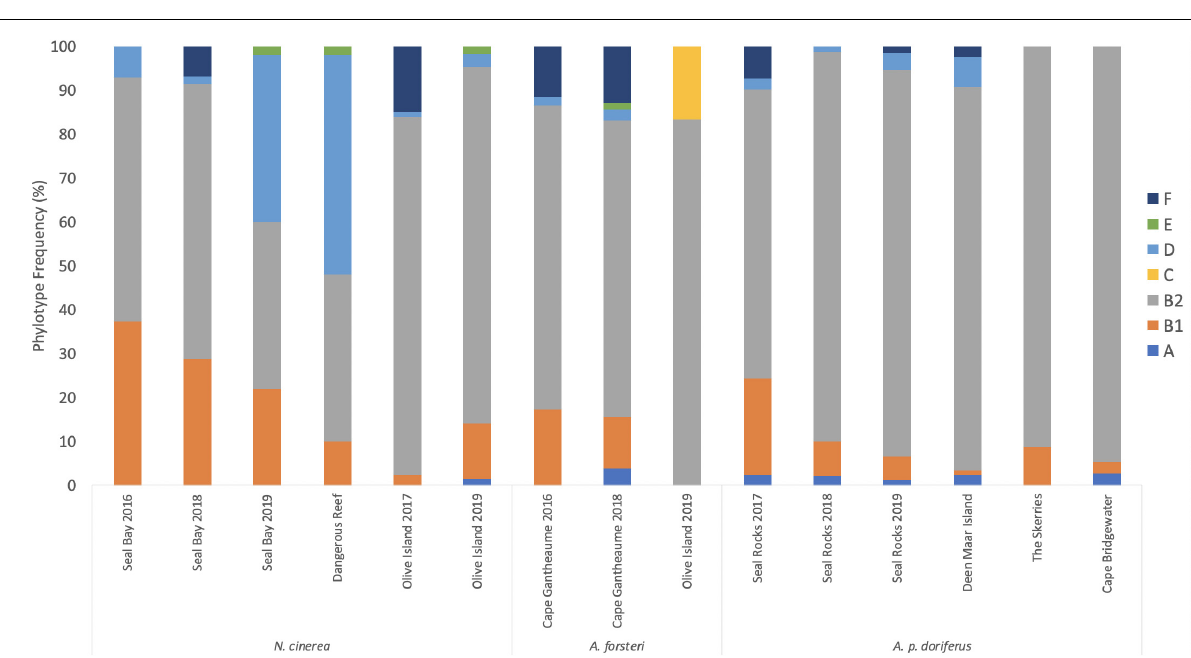
FIGURE 3 | Distribution of E. coli phylotypes across breeding season for each pinniped species across the eight sampling sites between 2016 and